Question: Does the plotted quantity increase or decrease?
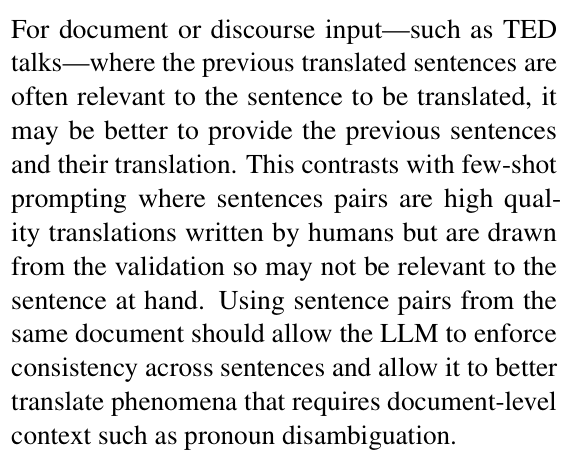
Answer: increasing